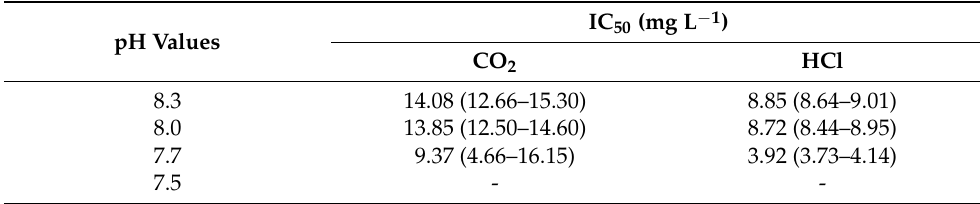
Figure 5. P. perna larval development success results after exposure to CC and acidification at two different pH values (8.0 on the ( left ) and 7.7 on the ( right )). The letter “a” indicates a significant ( p < 0.05) difference compared to results at the N treatment (reconstituted seawater). Similarly, letter “b” indicates a significant ( p < 0.05) difference between CC concentrations in different acidified methods. Table 3. Values of IC 50 derived from CC concentrations at the different pH values promoted by HCl and CO 2 acidification methodologies.